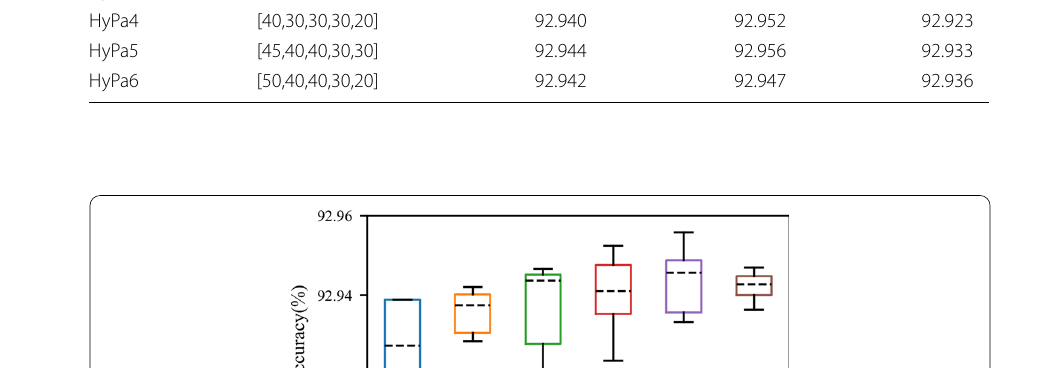
Table 8 The accuracy of models with different hyperparameters No Recurrent neurons Accuracy (Tst) HyPa1